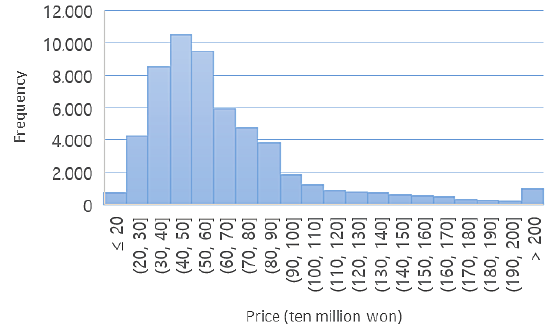
Figure 6. A histogram of the distribution of